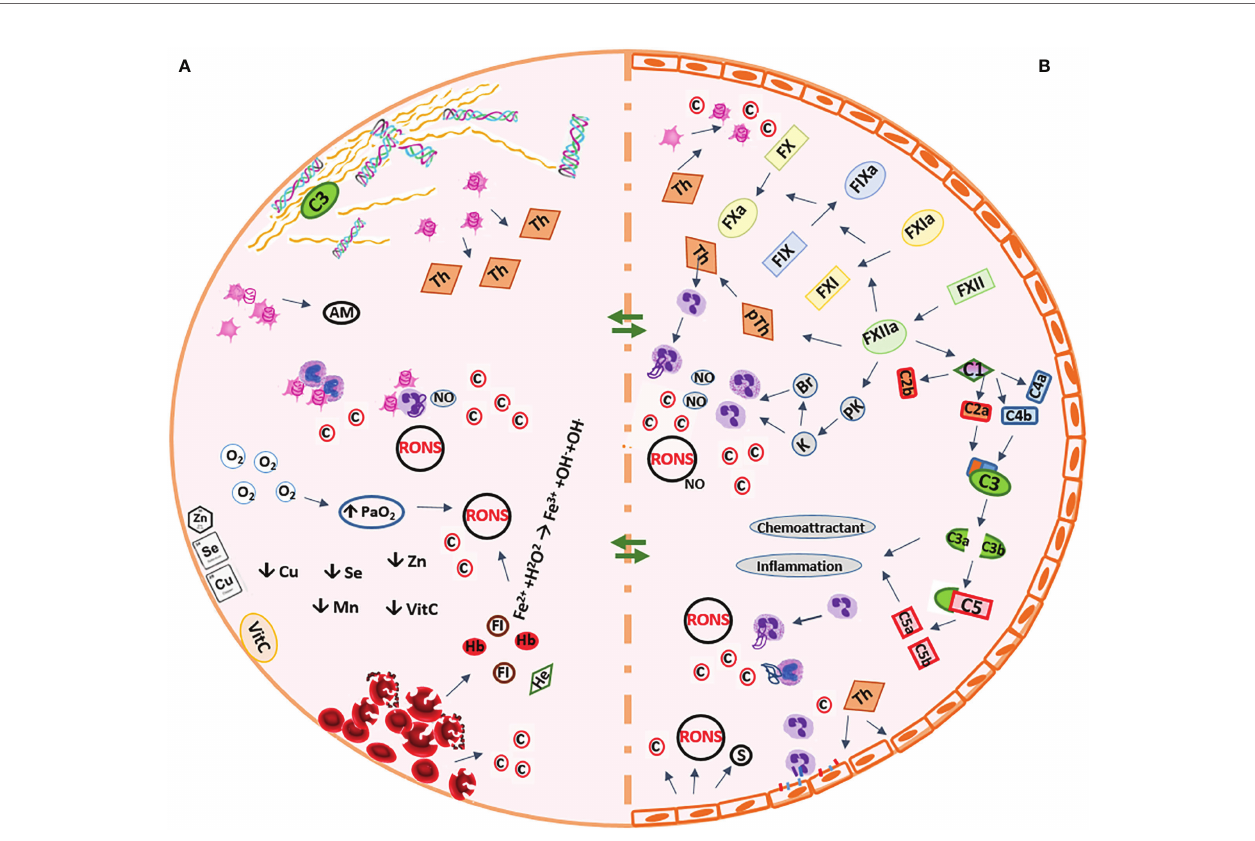
FIGURE 1 | Summary of the pathophysiologic conditions occurring during extracorporeal circulation. (A) Arti fi cial biomaterial of the circuit (B) Vascular system of the organs AM, adhesion molecules; Br, bradykinin; C, complement compartment, c, cytokines; Cu, copper; Fe 2+ , ferrous ion; Fe 3+ , ferric ion, FI, free iron; H 2 O 2 , hydrogen peroxide; He, heme; FIX, factor-9; FX, factor-10; FXI, factor-11; FXII, factor-12; K, kallikrein; Mn, manganese; NO, nitric oxide; O 2 , oxygen; OH - , hydroxyl; OH., hydroxyl radicalPaO 2 , partial pressure of arterial oxygen; PK, pre-kallikrein; pTh, prothrombin; RONS, reactive oxygen and nitrogen species; s, selectins; Se, selenium; Th, thrombin; VitC, vitamin C; Zn, zinc; , monocyte; , neutrophil; , red blood